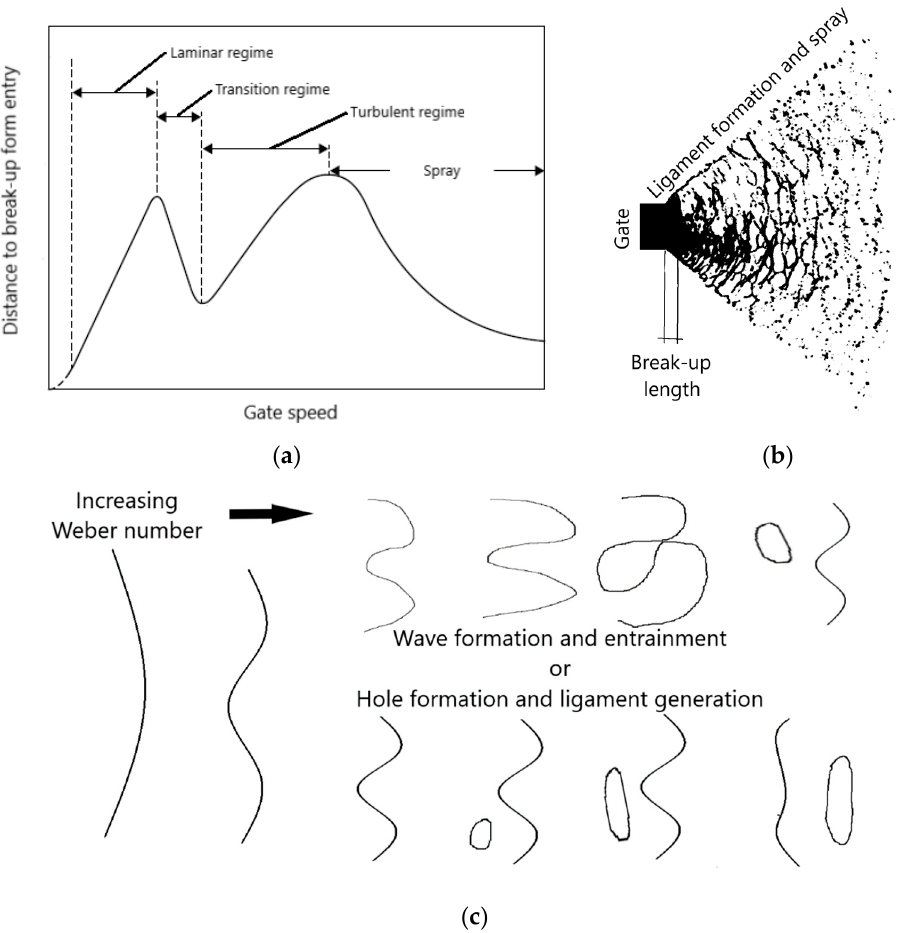
Figure 1. Break-up illustration with ( a ) Schematic illustration of the travelled distance before break-up and gate speed adapted from Lefebvre and McDonnel [11]. ( b ) Break-up distance of flat jet with ligament formation for partially filled die cavities and ( c ) different instabilities with surface wave formation and entrainment for a filled fie cavity and hole formation and ligament formation for a partially filled cavity.